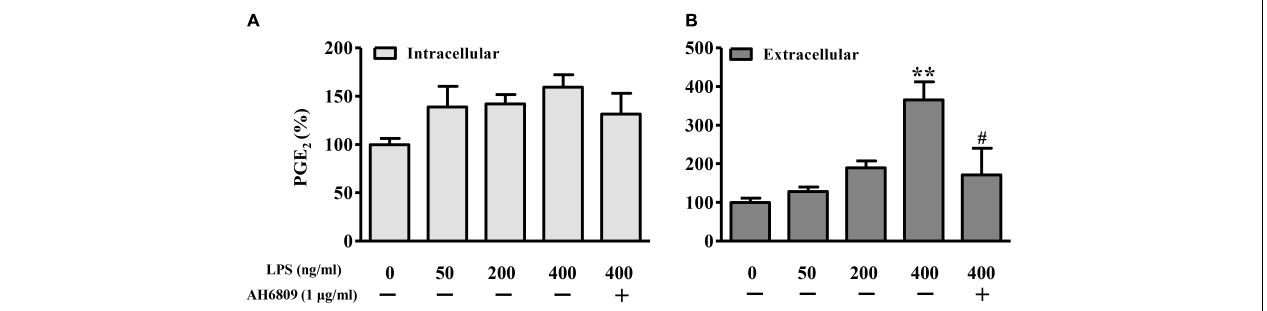
FIGURE 6 | Lipopolysaccharide induced PGE 2 production in NIH3T3 cells. The NIH3T3 cells were plated on plated on 35-mm dishes and incubated with LPS or AH6809 for 24 h. Both (A) intracellular and (B) extracellular PGE 2 concentrations were detected using ELISA method. ∗ P < 0.05, ∗∗ P < 0.01 vs. control; # P < 0.05 vs. the LPS (400 ng/mL) group, n = 5.